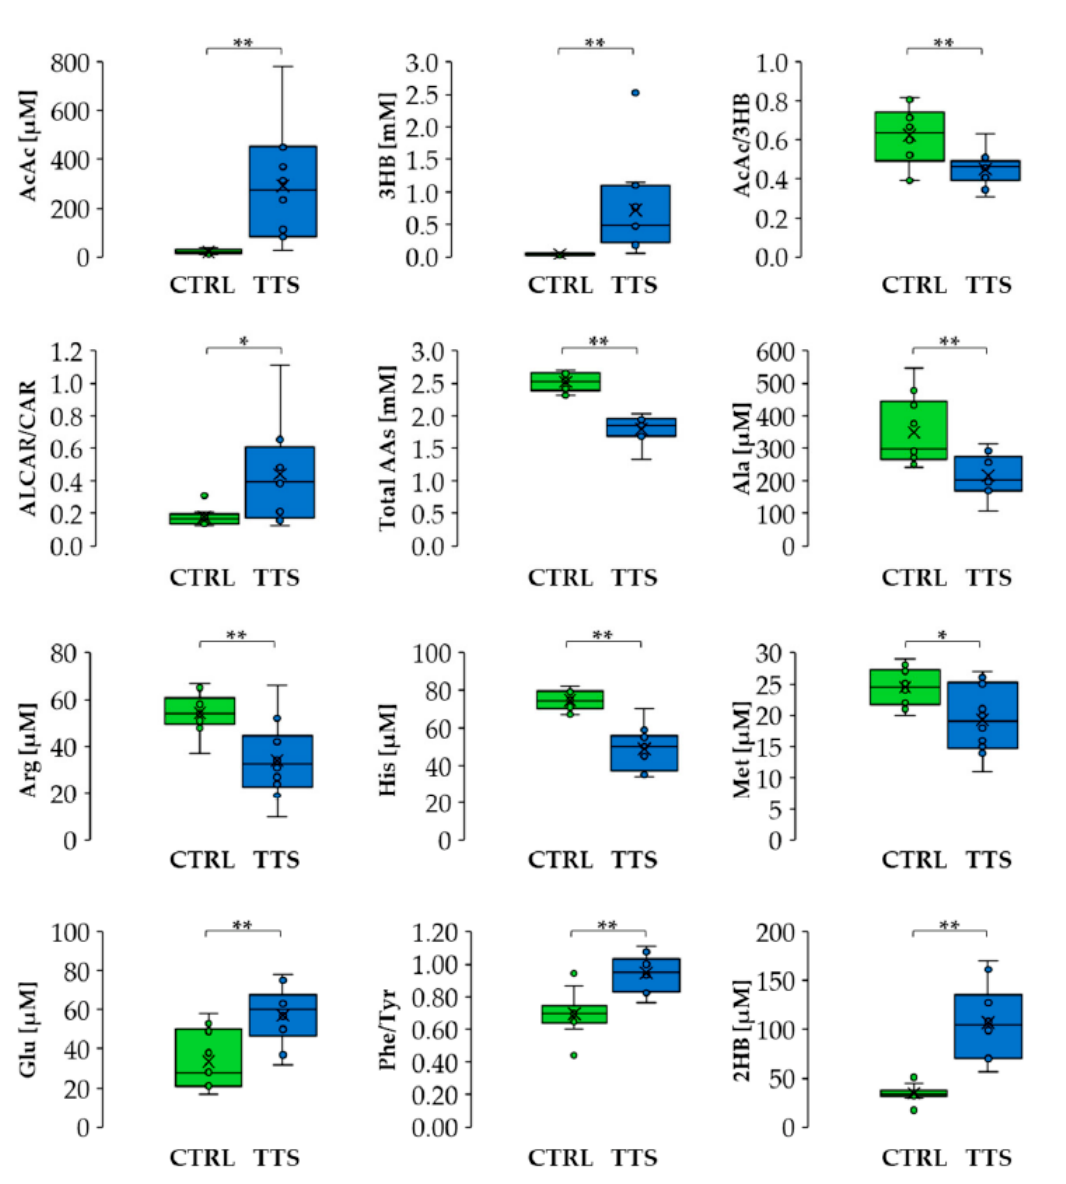
Figure 4. Differences in metabolite levels and ratios between CTRL and TTS. Boxes denote IQR, lines denote the median, whiskers denote the 5th and 95th percentile, and x denotes the average. * p < 0.05, ** p < 0.01. Abbreviation used: AcAc: acetoacetate; 3HB: 3-hydroxybutyrate; ALCAR: acetyl-L- carnitine; 2HB: 2-hydroxybutyrate; CAR: L-carnitine; Ala: alanine; Arg: arginine; His: histidine; Met: methionine; Glu: glutamate; Phe: phenylalanine; Tyr: tyrosine. (Reprinted with permission from Vanni D et al. Antioxidants (Basel). 2021, 10, 1982).